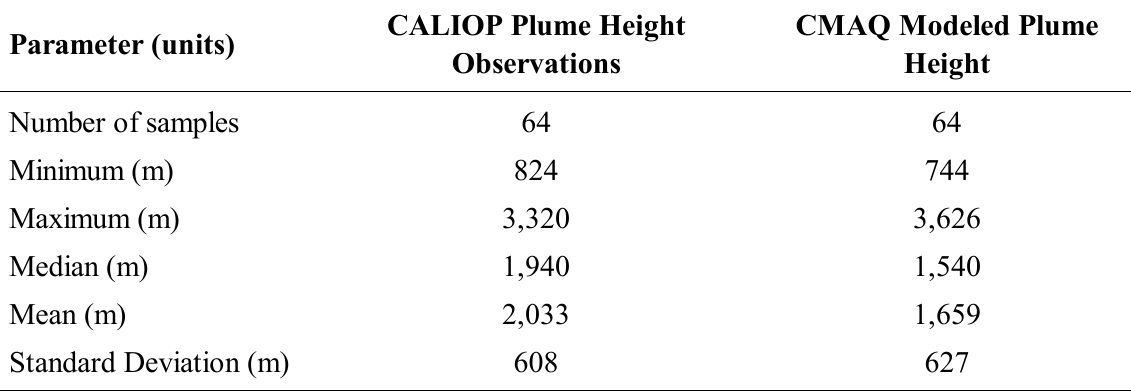
Table 3. Comparison of the overall distributions of observed plume top heights from the CALIOP instrument and modeled plume heights from CMAQ as in Table 1. Plume height units are meters above ground level.